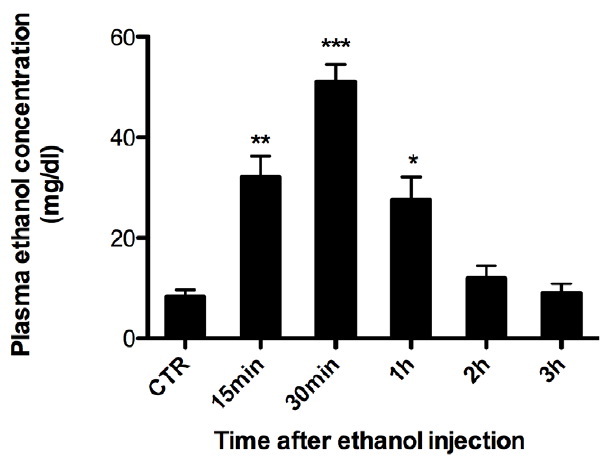
Figure 1. Plasma ethanol concentrations in mice after ethanol administration. Mice received an i.p. injection of 5% ethanol at a dose of 1 g/kg body weight were sacrificed at indicated time after, and plasma ethanol concentration were assayed. The CTR group did not receive any ethanol. Results are mean values 6 SEM ( n =4–6). (* p , 0.05, ** p , 0.01, *** p , 0.001; in comparison with the CTR group).